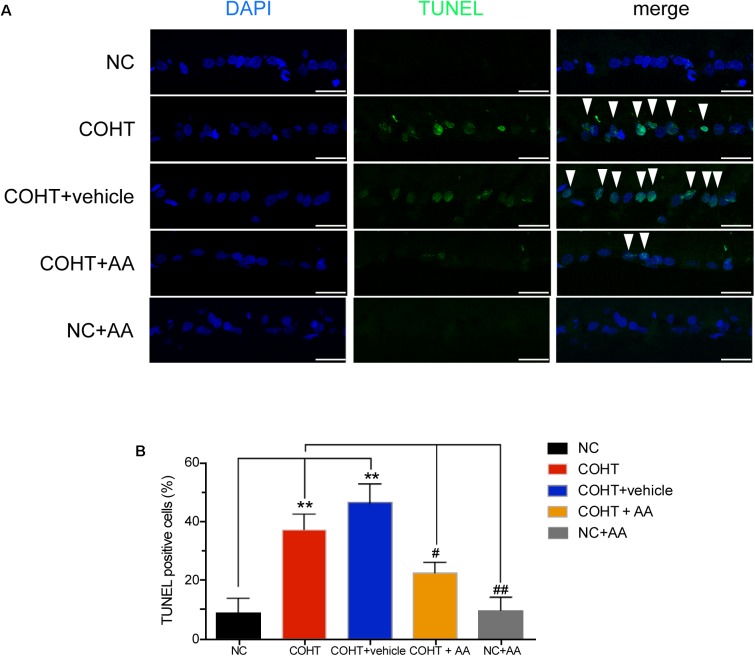
TUNEL staining of the five groups 2 weeks after induction of COHT. (A) Images of TUNEL staining in the GCL of retinal sections. The NC group showed a normal GCL without TUNEL-positive cells. The COHT and COHT+vehicle groups showed a large number of TUNEL-positive cells. The COHT+AA and NC+AA groups showed lower number of TUNEL-positive cells in the GCL. Scale bar: 25 μm. (B) Quantitative analysis of percentages of TUNEL-positive cells in the GCL at 2 weeks. Data are presented as mean ± SEM. #p < 0.05, ##p < 0.01, compared to the COHT group; ∗∗p < 0.01, compared to the NC group (n = 6 per group).